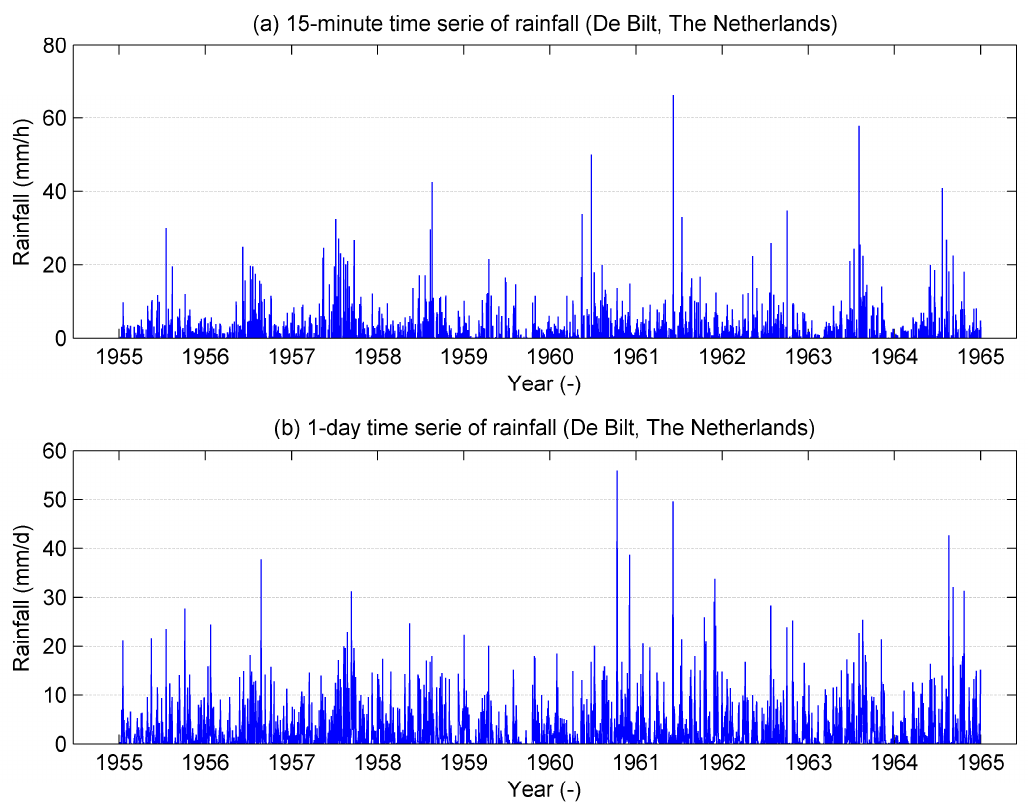
Figure 4. Long-term rainfall series of De Bilt (The Netherlands). Observed rainfall volumes (by the Royal Dutch Meteorological Institute) during the period 1955–1964. ( a ) 15-min time serie of rainfall; ( b ) 1-day time series of rainfall.